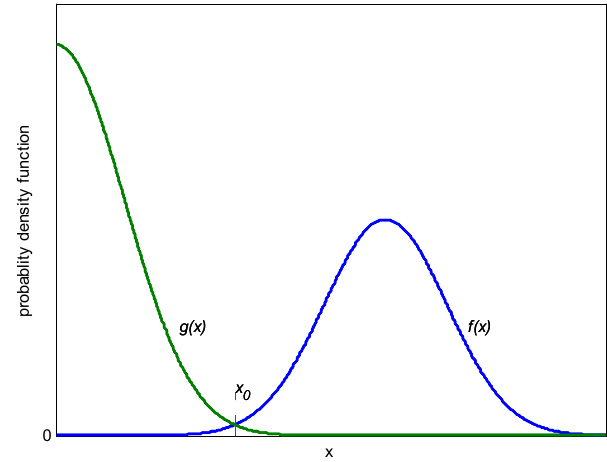
Figure 4. The probability density function curves of | L ( b i )| and | L ( b k )|.